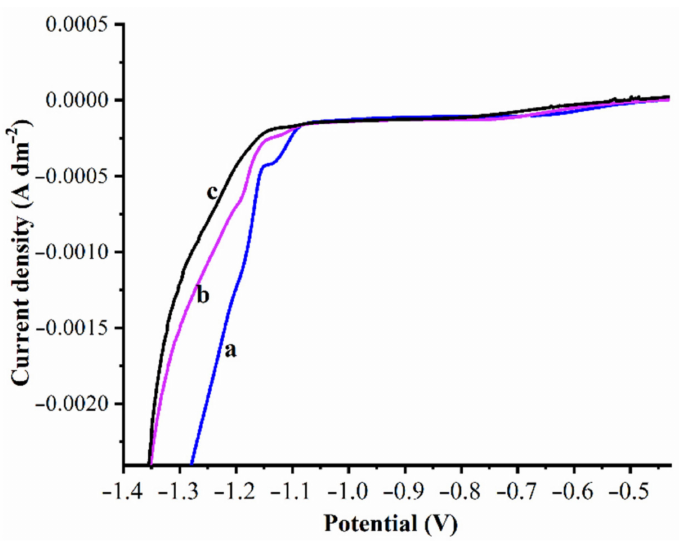
Figure 3. Cathodic polarization curves: ( a ) Zn ( b ) Zn–WO 3 (0.5 g/L) and ( c ) Zn–WO 3 (1.0 g/L)